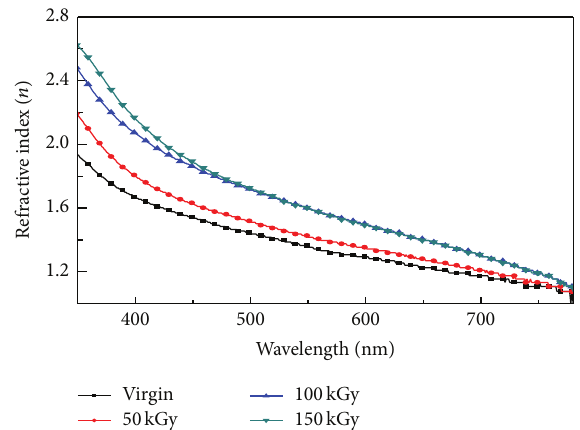
Figure 4: Variation of refractive index as a function of wavelength.